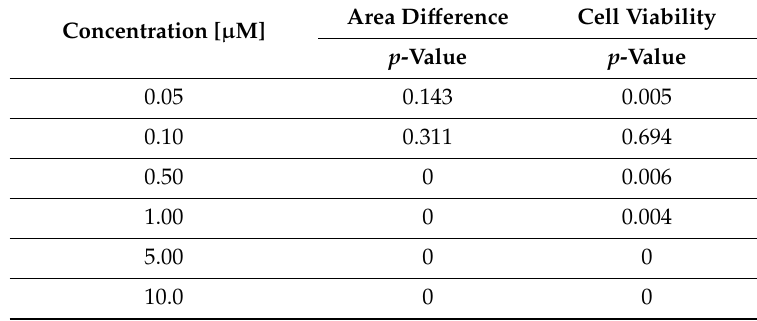
Table 1. ANOVA P-Values for small MCF-7 spheroid area di ff erence and cell viability. Concentration [ µ